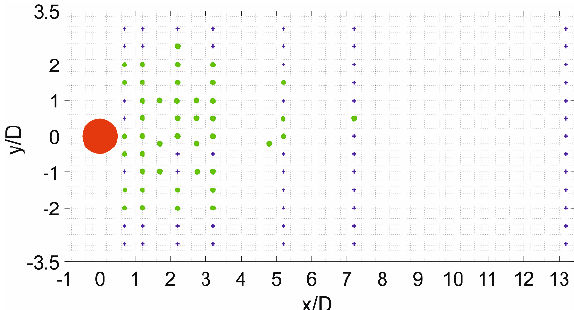
Fig. 2. Positions of hot wire probe behind the single circular cylinder, ● – positions with two strength frequencies, + - positions with only one or any frequencies.